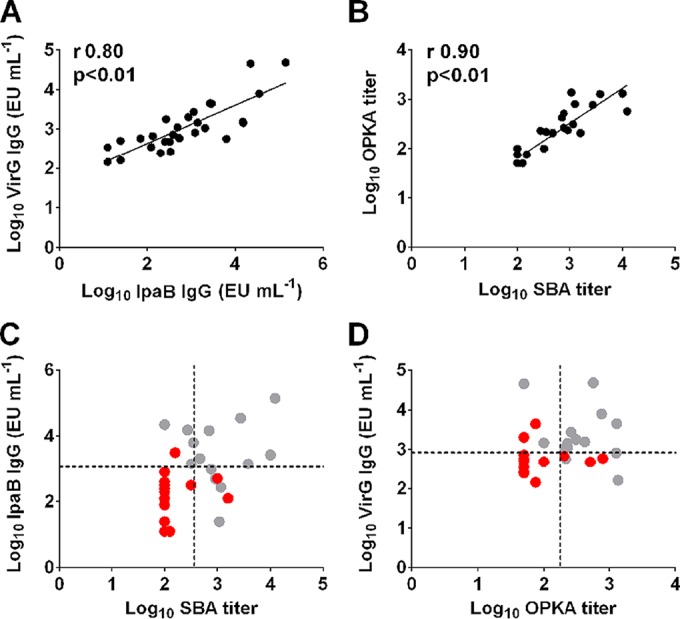
Serological trends associated with reduced disease severity. (A and B) Associations between IpaB- and VirG-specific serum IgG titers (A) and between SBA and OPKA titers (B) in EcSf2a-2 vaccine recipients and nonvaccinated controls prior to challenge. (C and D) Serological trends of IpaB and SBA titers (C) and VirG and OPKA titers (D) associated with disease severity. Gray circles represent individuals who remained healthy or had mild symptoms postchallenge (n = 14), and red circles represent those who experienced moderate to severe disease (n = 14). Dotted lines represent IpaB-specific IgG titers of ≥1,500 EU ml−1, VirG titers of ≥700 EU ml−1, and SBA and OPKA endpoint titers of ≥200.